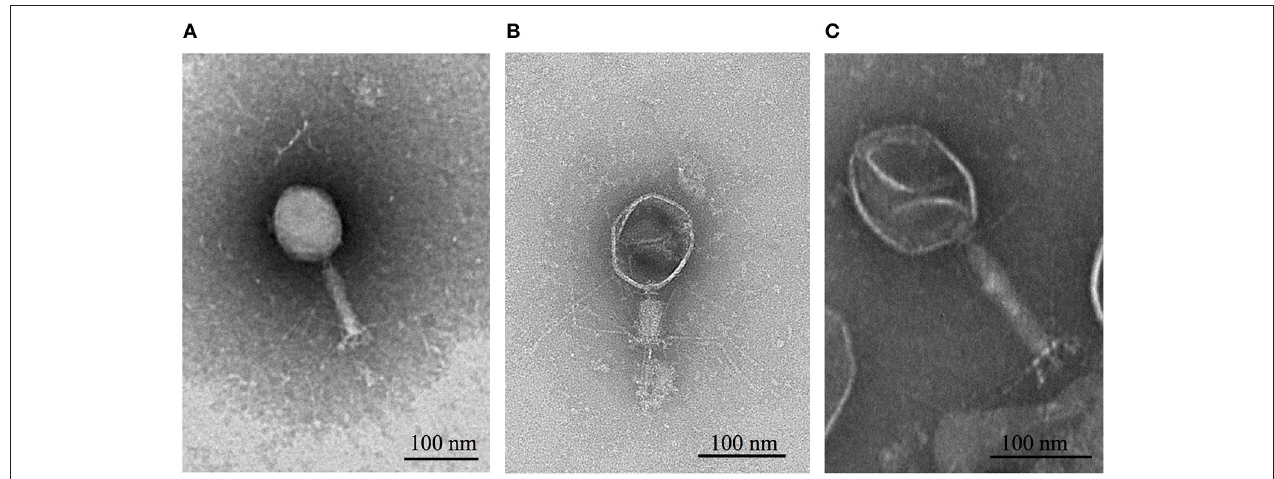
FIGURE 1 | TEM images of (A) 8 CHI14, (B) 8 X20, and (C) 8 CBH8. 8 CHI14 and 8 CBH8 have extended tails while 8 X20 captured in the images shows a contracted tail.